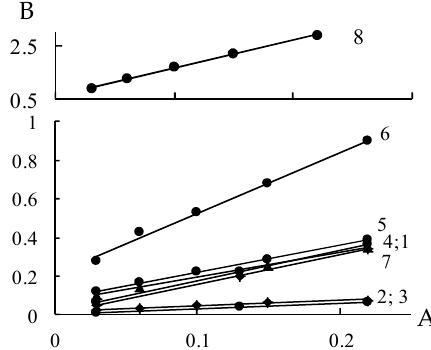
Figure 4. Initial linear portions of the BET adsorption isotherms for the manganese oxide samples under study A = P/P s ; B = A/ a (1 − A). Indexation 1–8 corresponds to Arabic numerals in the sample designations.